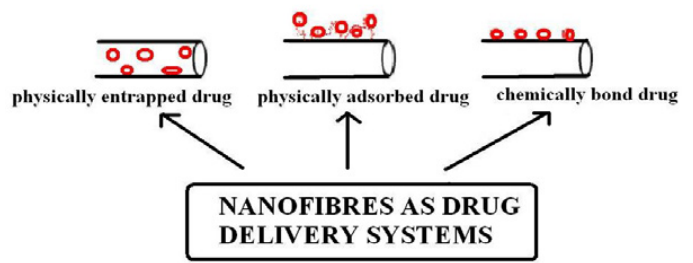
Fig. 3. Scheme of interactions between drug and Nano-fibers.